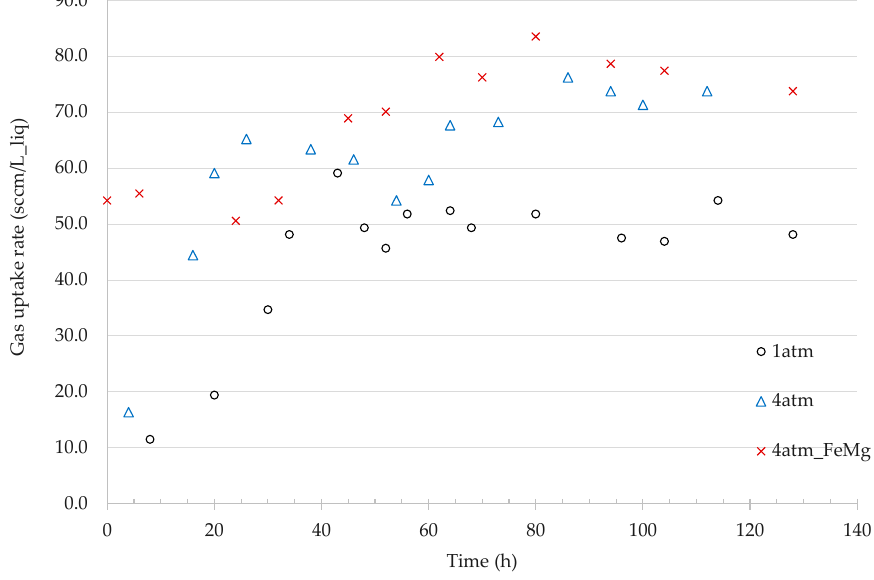
Figure 5. Gas uptake rates under different gas pressures (1 atm and 4 atm). See Table 2 for the fermentation conditions and the concentrations of Fe and Mg. The amounts of Fe and Mg were doubled in one fermentation (4 atm_FeMg). Table 3. The inlet and outlet gas flow rates and gas compositions at the end of fermentations.